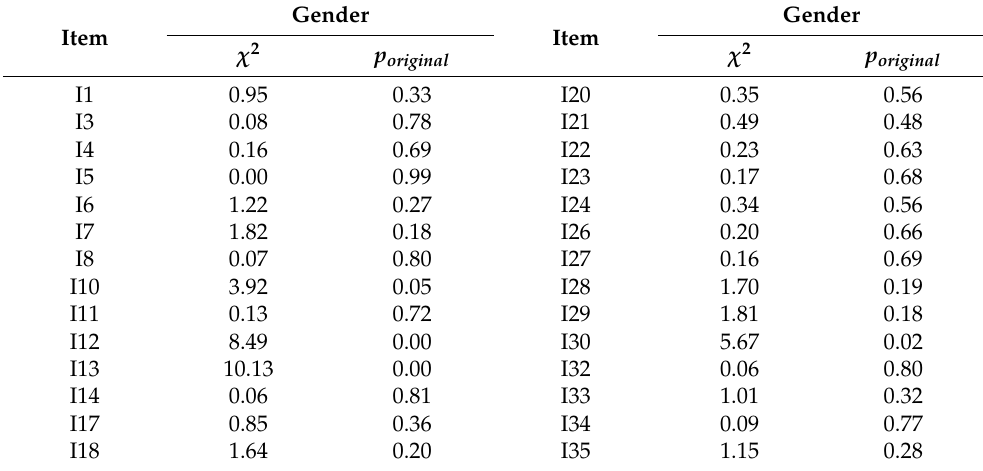
Table 6. The results of Differential item functioning (DIF) by gender for D28-C.